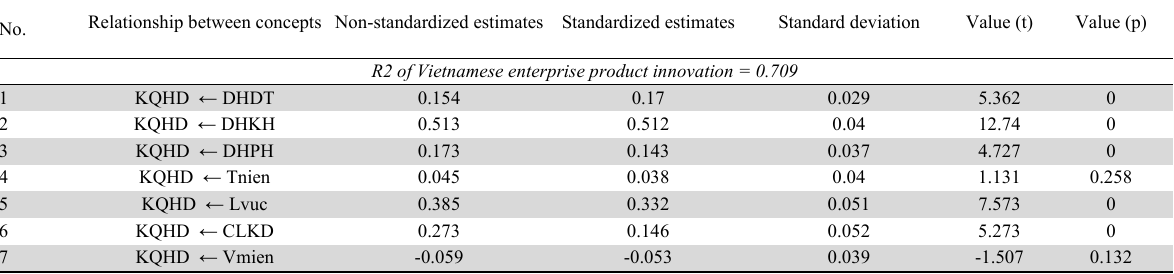
Estimation results of the standardized model (SEM) No. Relationship between concepts Non-standardized estimates Standardized